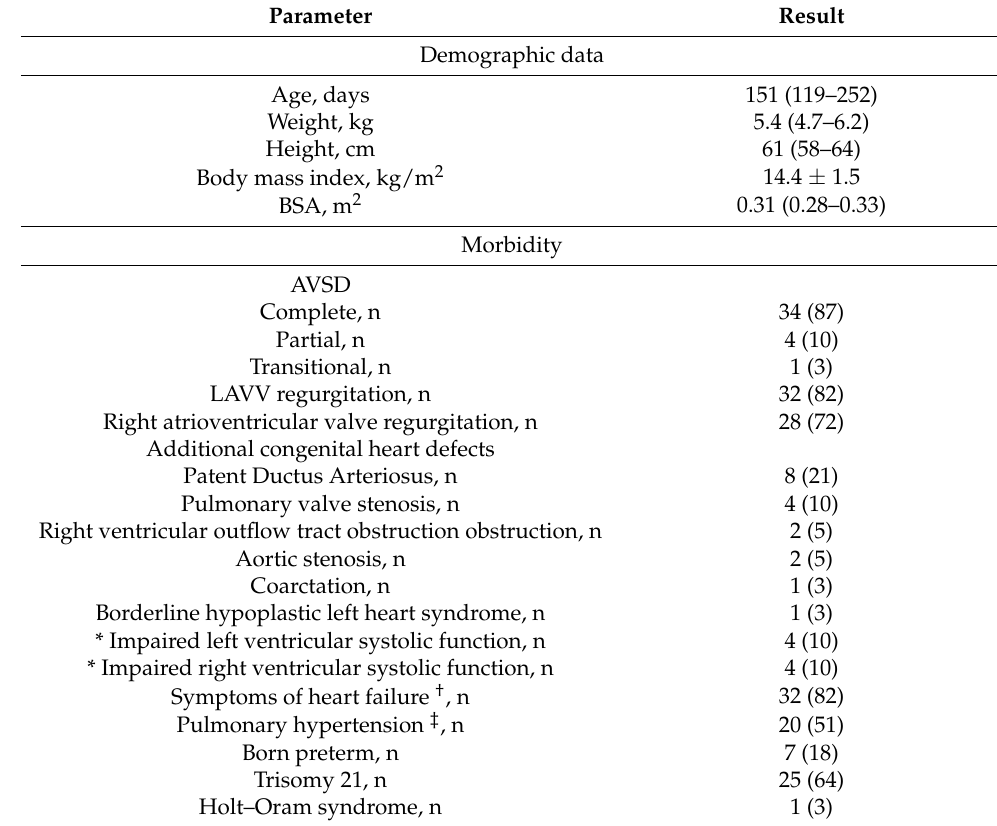
Table 1. Baseline demographic and clinical characteristics of the study